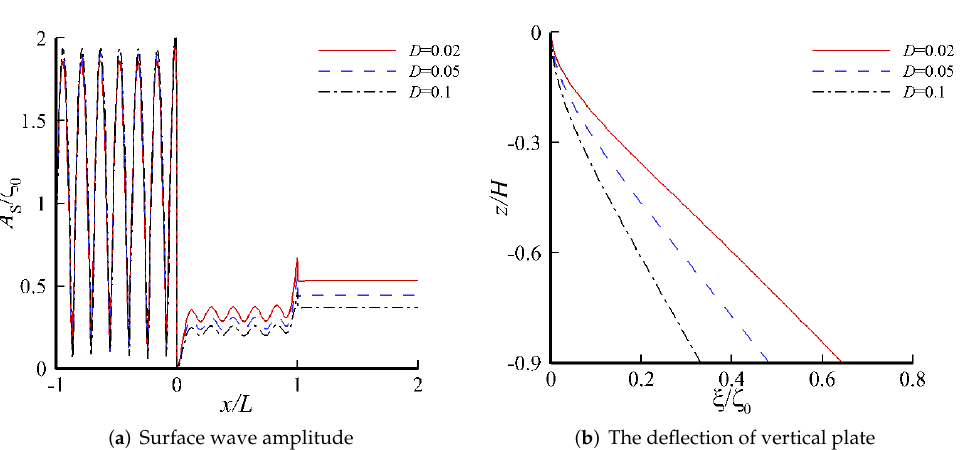
Figure 10. Wave amplitudes A S ( x ) and deflection of vertical plate ξ ( z ) for the different flexural rigidity D .